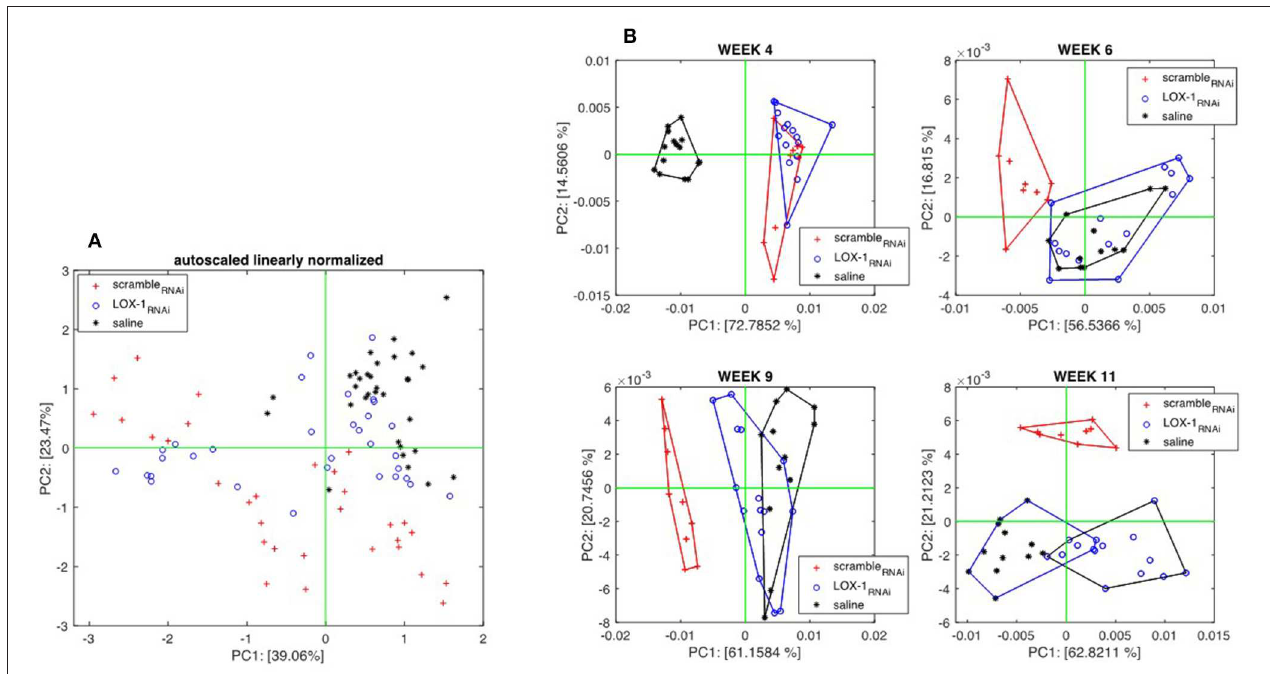
FIGURE 6 | Principal component analysis of sensors data collected from endovenously injected mice. (A) Scores Plot of the first two principal components of the PCA calculated with the whole data set. Each group contains measures taken at different times. (B) Scores plots of PCA calculated with data collected in the individual experimental sessions held at weeks 4, 6, 9, and 11 after the injection. Score plots shows that, after the sixth week, the volatilome of the group of mice injected with scramble RNAi cells are distinct from the